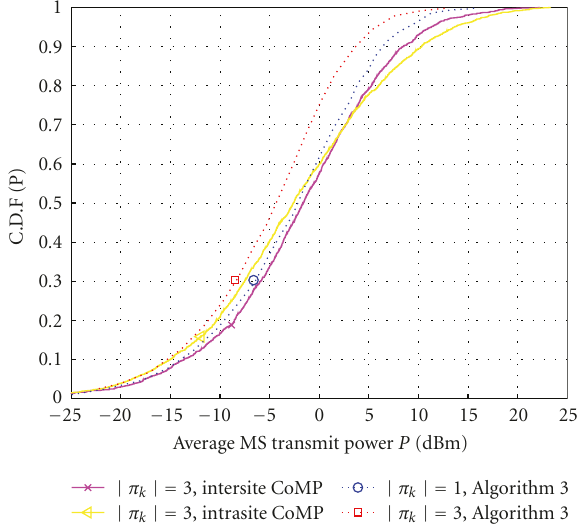
Figure 10: Comparison of CDFs of transmit power of inter-site, intra-site and adaptive reception schemes with the SINR constraint of 8dB.